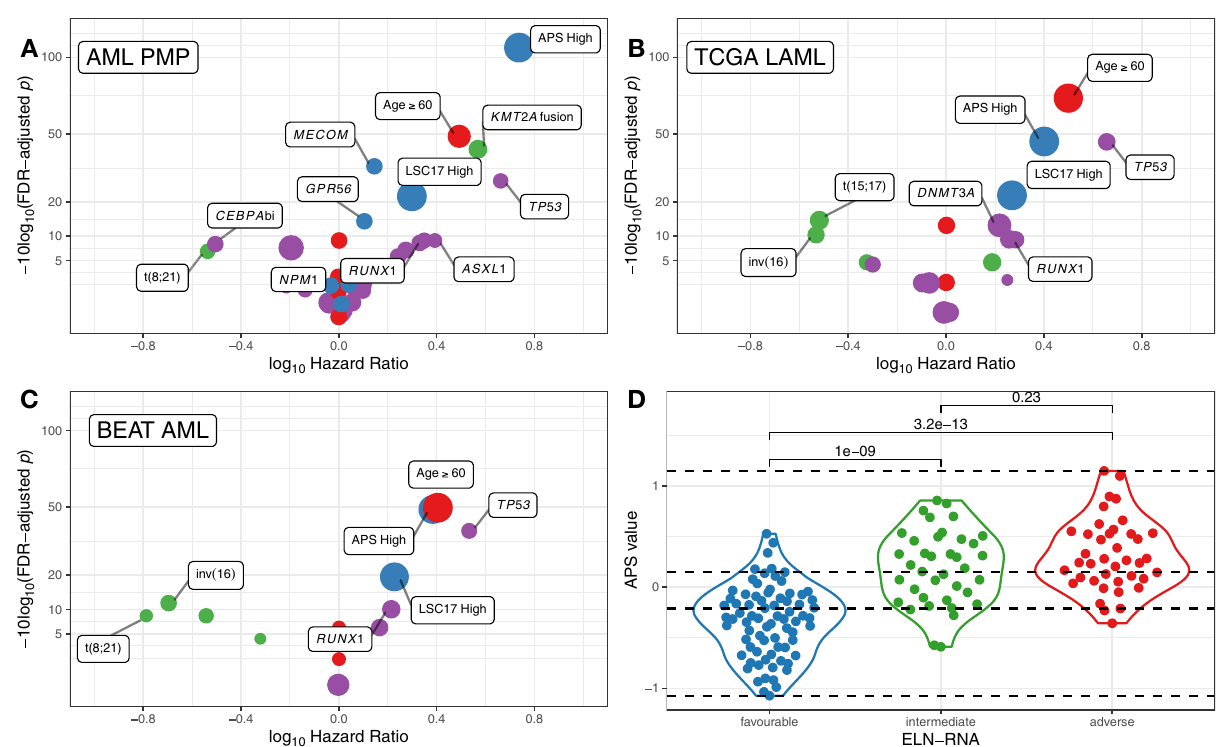
Fig. 4 Univariate survival analysis. A – C Univariate survival analysis for selected clinical, gene fusion, mutation, strati fi cation, and expression-based predictors of survival for the AML PMP ( A ), TCGA LAML ( B ), and Beat AML ( C ) cohorts. In each panel, the x -axis indicates the hazard ratio, and the y -axis indicates the FDR-adjusted p -value for each tested variable for univariate Cox proportional hazards models. Point sizes are scaled to re fl ect the proportion of patients affected by the relevant marker, and colored as clinical variables — red, gene fusions — green, SNV/indels — purple, expression — blue. D Distribution of APS values for AML PMP patients, colored by ELN-RNA risk status (favorable — blue, intermediate — green, adverse — red). Horizontal dashed lines indicate the bottom, intermediate, and top terciles of the APS value distribution. Comparison bars show two-sided Wilcoxon test p -values for each pairwise